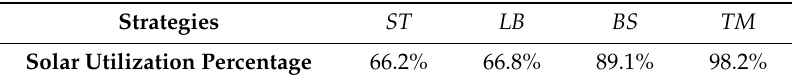
Table 2. Solar utilization percentage under sunny weather Table 3. Solar utilization percentage under cloudy (rainy) weather condition.